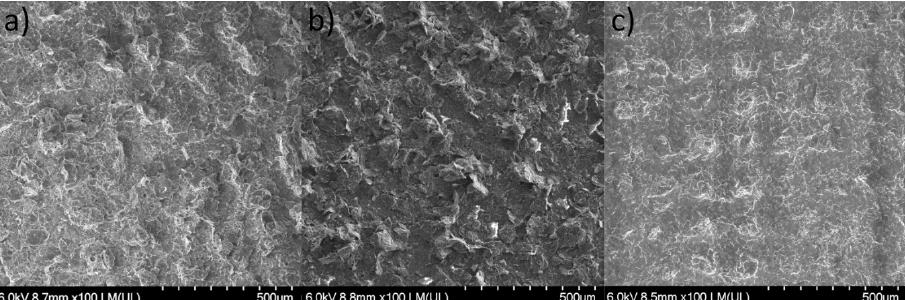
Figure 5. Comparison of SEM images of layers containing 15% packing of graphene based on LARO ( a ), PMMA ( b ), and soft TPU ( c ).